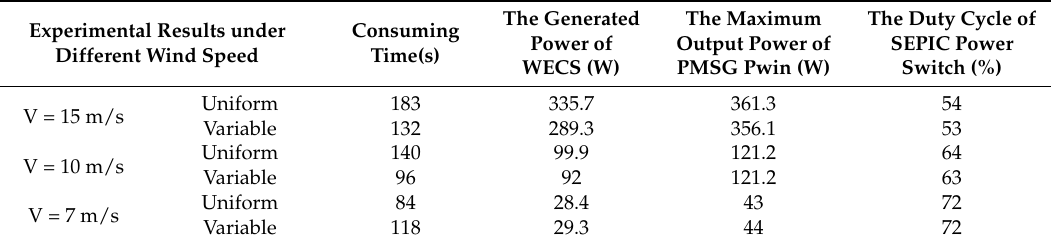
Table 1. The experimental results of the uniform hill-climbing and the variable hill-climbing method. Experimental Results under Different Wind Speed